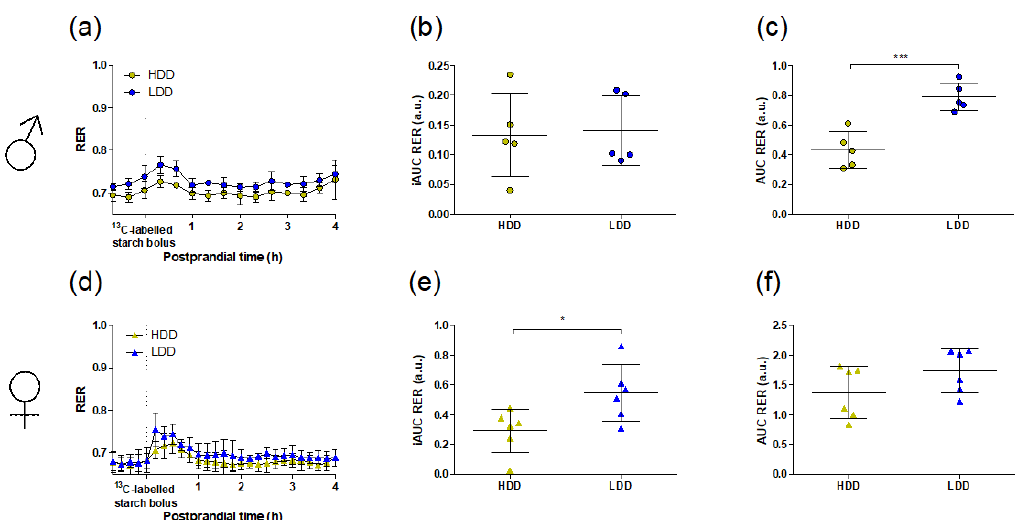
Figure 2. Whole-body substrate oxidation after oral administration of a 13 C-labelled starch bolus to HDD and LDD mice in PW 4. ( a , d ) respiratory exchange ratio (RER) evolution after administration of the starch bolus. ( b , e ) iAUC and ( c , f ) AUC of the RER response over 4 h from administration of the bolus. ( a – c ) Males ( n = 5), ( d – f ) females ( n = 6). Data are presented as mean and SD. Student’s t -test, * P < 0.05, *** P < 0.001. HDD, highly digestible-starch diet; iAUC, incremental area under the curve;